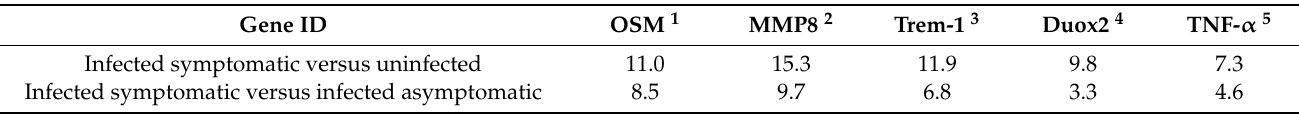
Figure 1. Kaplan–Meier survival curve of mice infected with C. difficile ATCC 43255 and uninfected mice. Table 1. Log 2 fold-change of selected genes between infected symptomatic mice when compared with uninfected or infected asymptomatic